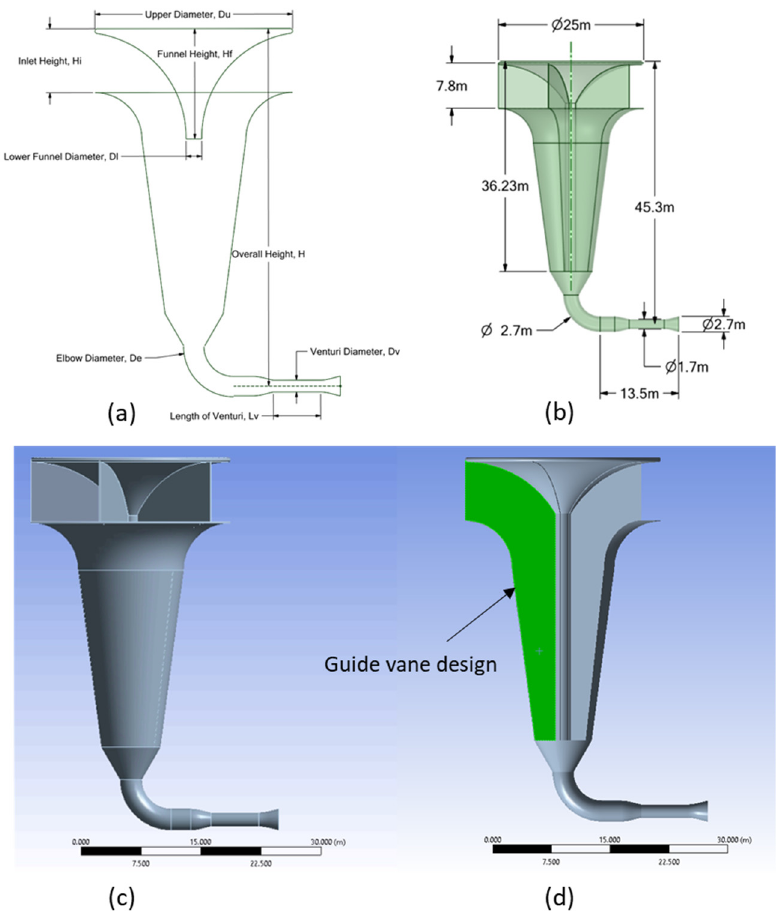
Figure 1. ( a ) Schematic drawing of the omni-directional wind funnel; ( b ) detailed dimension and geometry of the omni-directional wind funnel; ( c ) 3D model of the omni-directional wind funnel with the configuration of five fins at 72° each; ( d ) cross section of the 3D model.